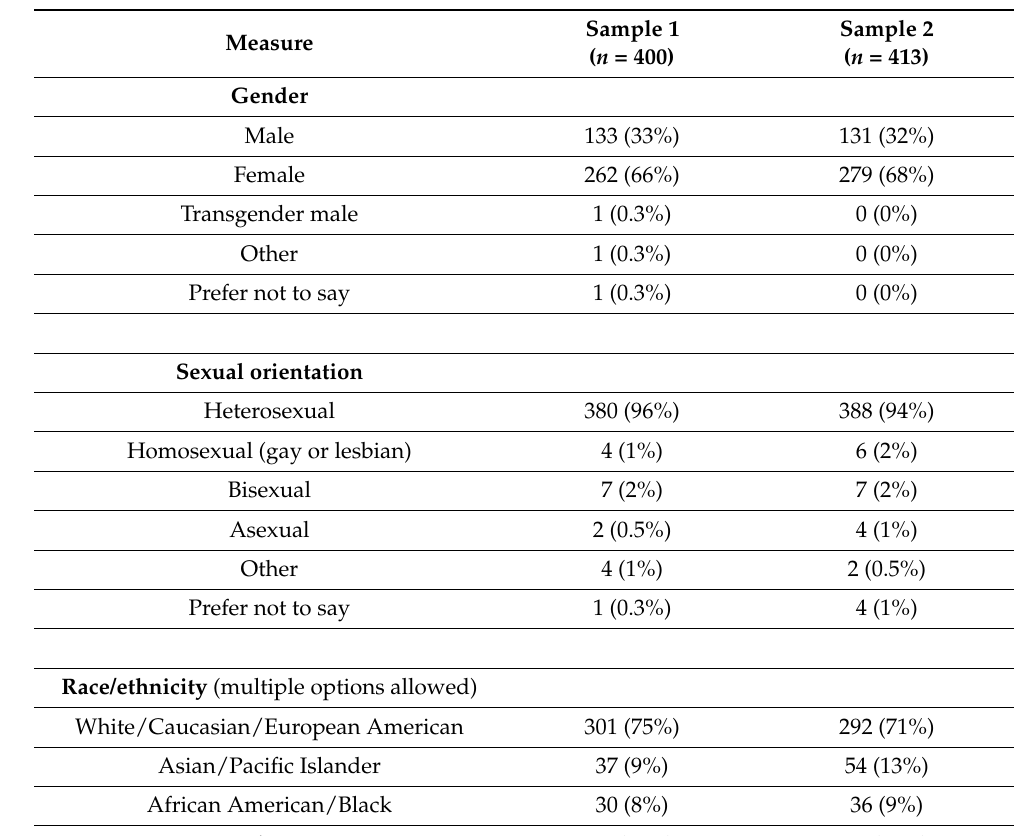
Table 1. Summary of Categorical Demographic Variables for Samples 1 and